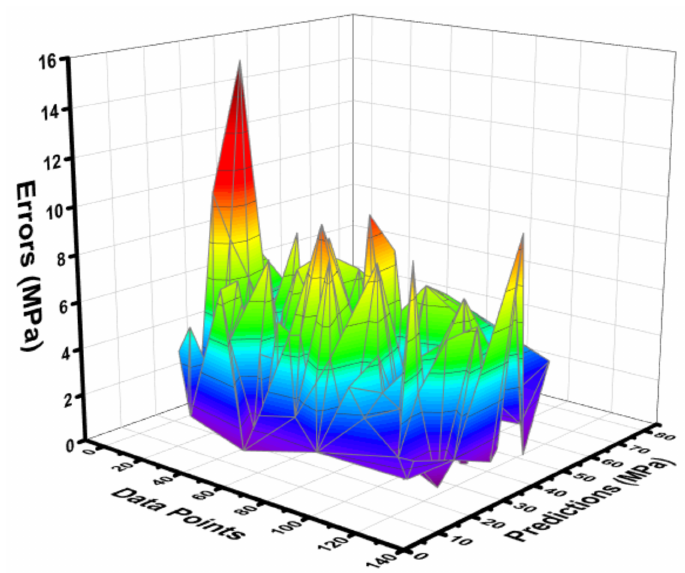
Figure 10. Difference between the experimental C-S and predicted C-S of the MLP model.